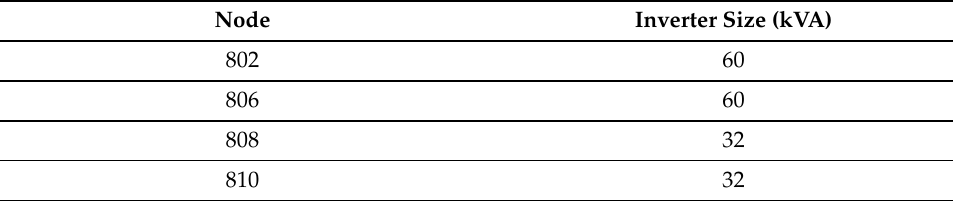
Table A2. Connected DER to the test